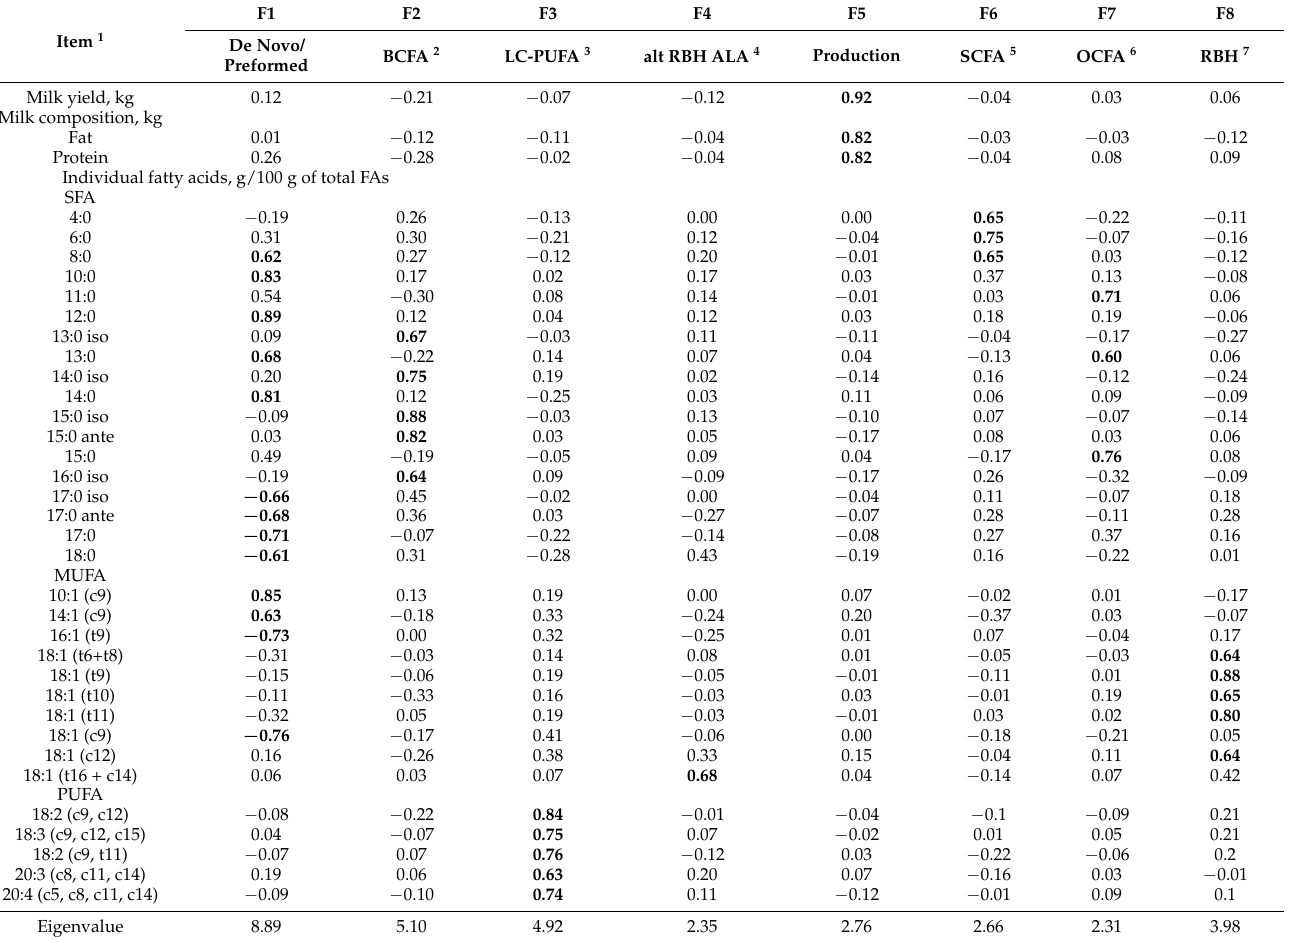
Table 2. Extracted factors from factor analysis and proposed factor